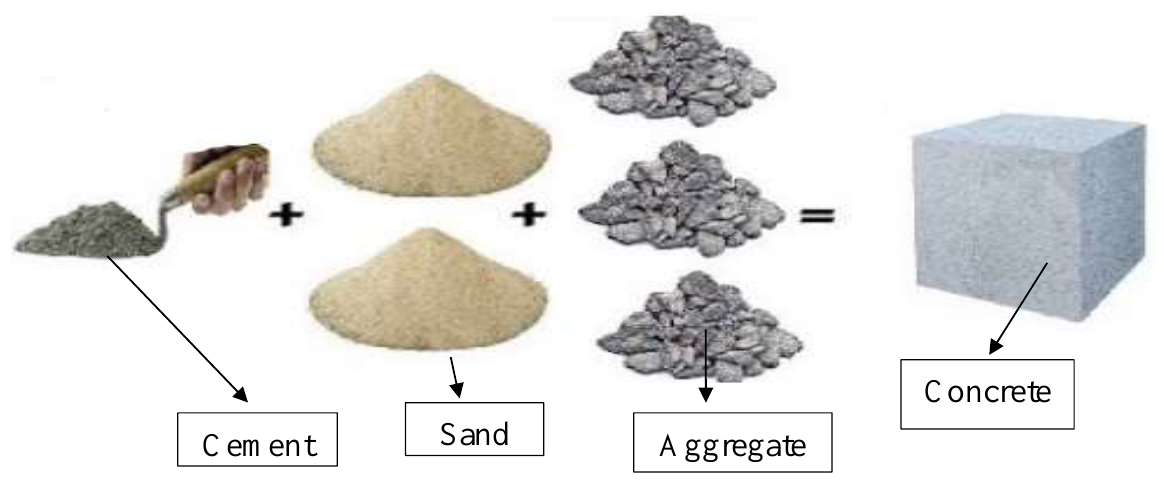
Figure 1: Traditional concrete material